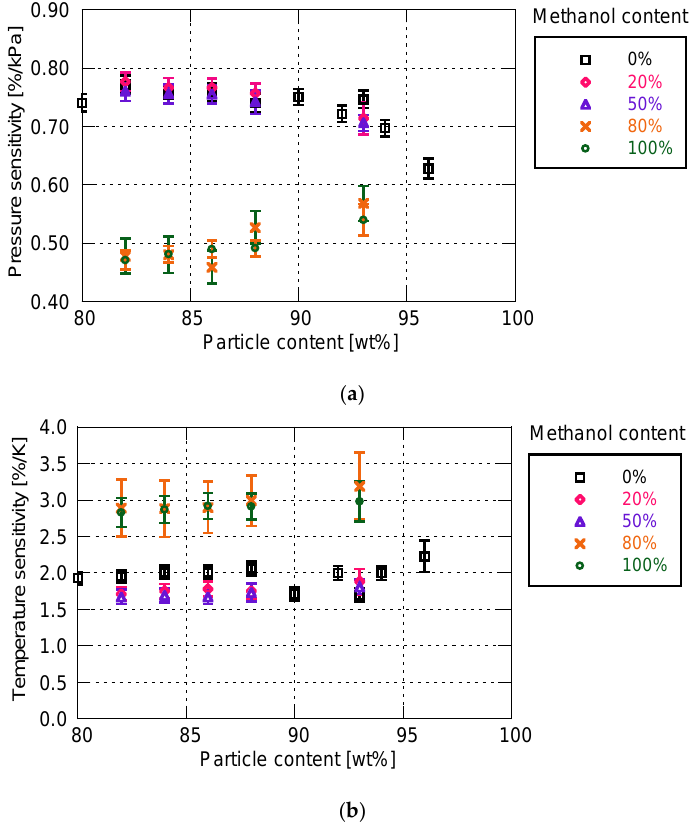
Figure 7. Static sensitivity characteristics related to methanol content for particle/dye solution. ( a ) Pressure sensitivity; ( b ) Temperature sensitivity.